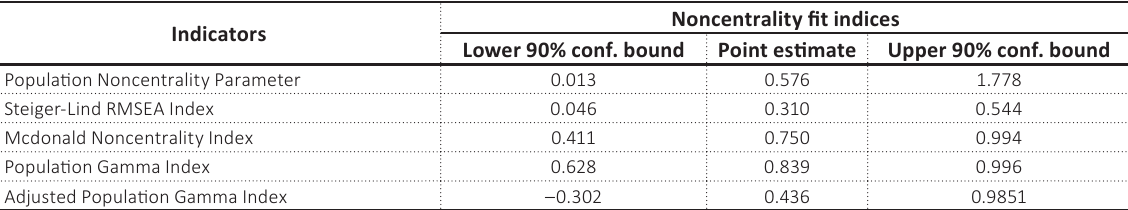
Table 6. Noncentrality indices of the model Indicators